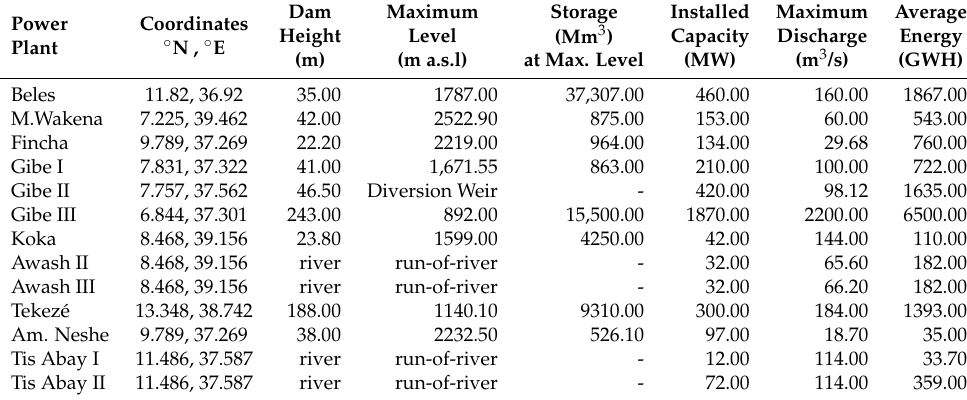
Table 1. Reservoir generation information and geographical location.